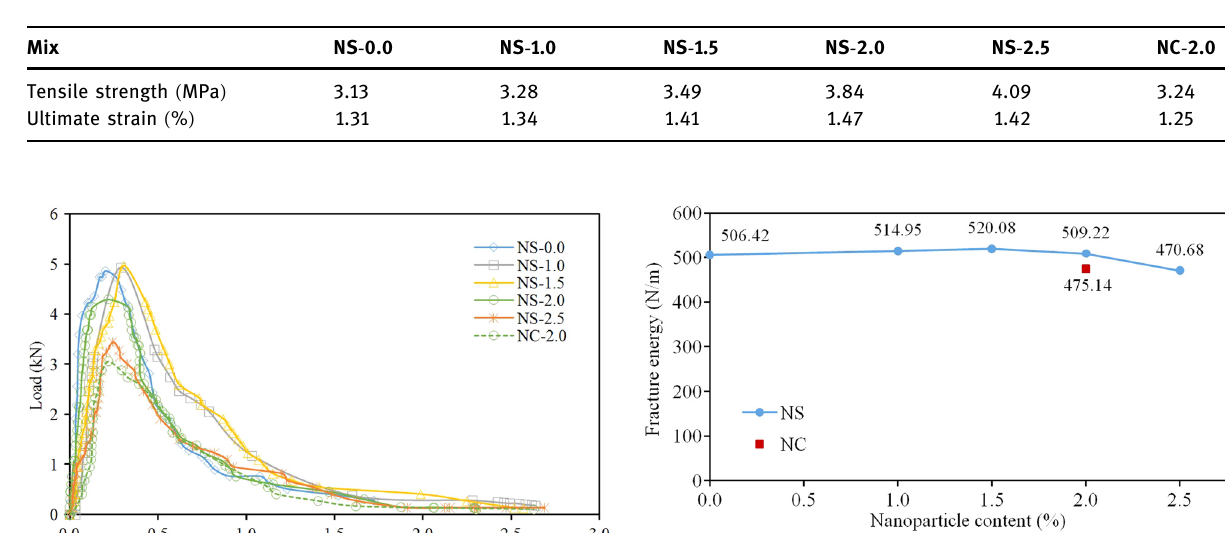
Figure 9: E ff ects of nanoparticle content and type on fracture energy.